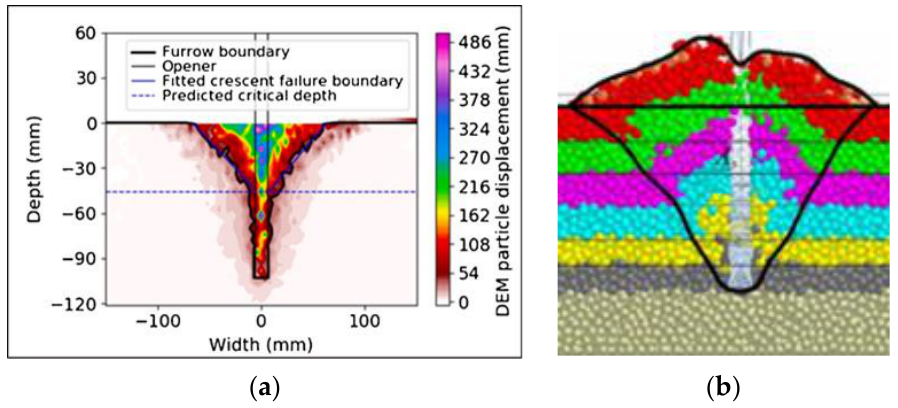
Figure 16 . Definitions of furrow boundary used by ( a ) Aikins et al. [41] and ( b ) Wang et al. [74].